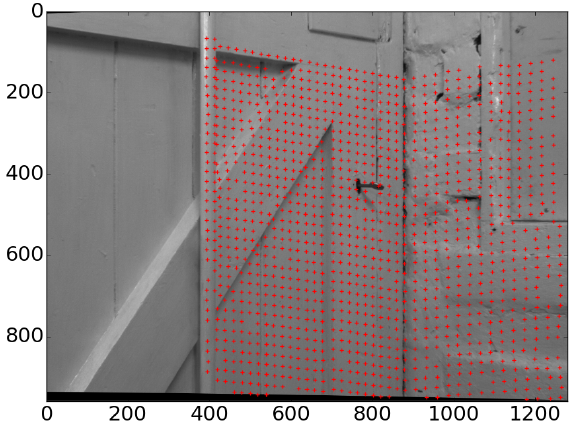
Figure 3 Epipolar-rectified left image of calibration scene, locations of calibration points are plotted.